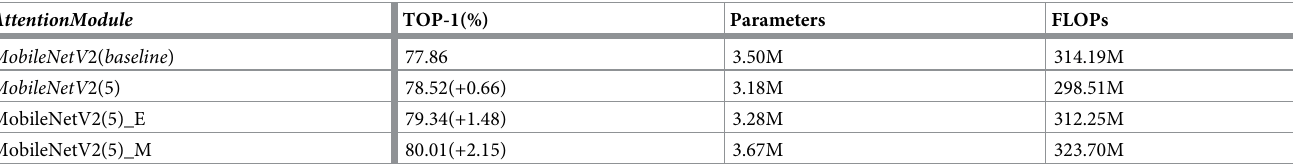
Table 6. Results for different position of attention module in bottleneck.